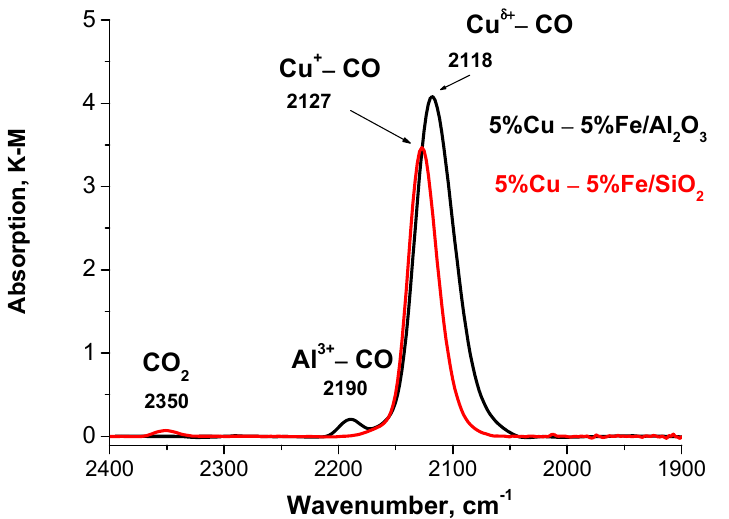
Figure 2. FTIR spectra of CO adsorbed at a pressure of 16 Torr and at room temperature on the 5%Cu-5%Fe/SiO 2 and 5%Cu-5%Fe/Al 2 O 3 samples. For the catalyst 5%Cu-5%Fe/Al 2 O 3 , the intensity of the band was enhanced substan- tially, and the position shifted to a low wavenumber, namely to 2118 cm − 1 , compared with that on the 5%Cu-5%Fe/SiO 2 sample (Figure 2). The band at 2118 cm − 1 characterizes linear carbonyl on electron-deficient copper cations (Cu δ + -CO) [26]. The presence of this band likely indicates strong interaction of copper and iron species in the 5%Cu-5%Fe/Al 2 O 3 sample, which is also consistent with the TPR-H 2 results for this catalyst (to be